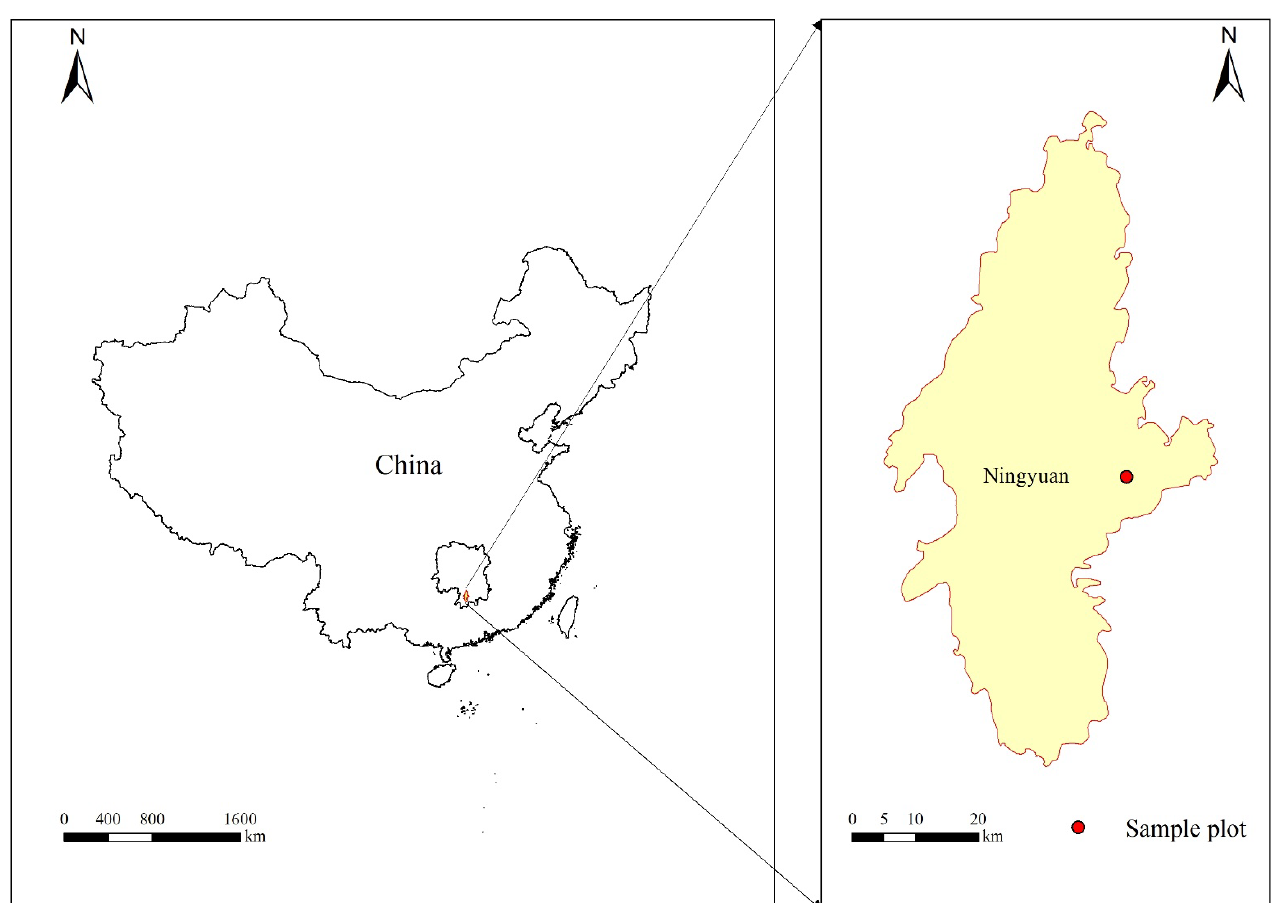
Figure 1. Sample location of Melaleuca alternifolia in Ningyuan county. Table 1. Contents of main nutrient elements in Melaleuca alternifolia residues.